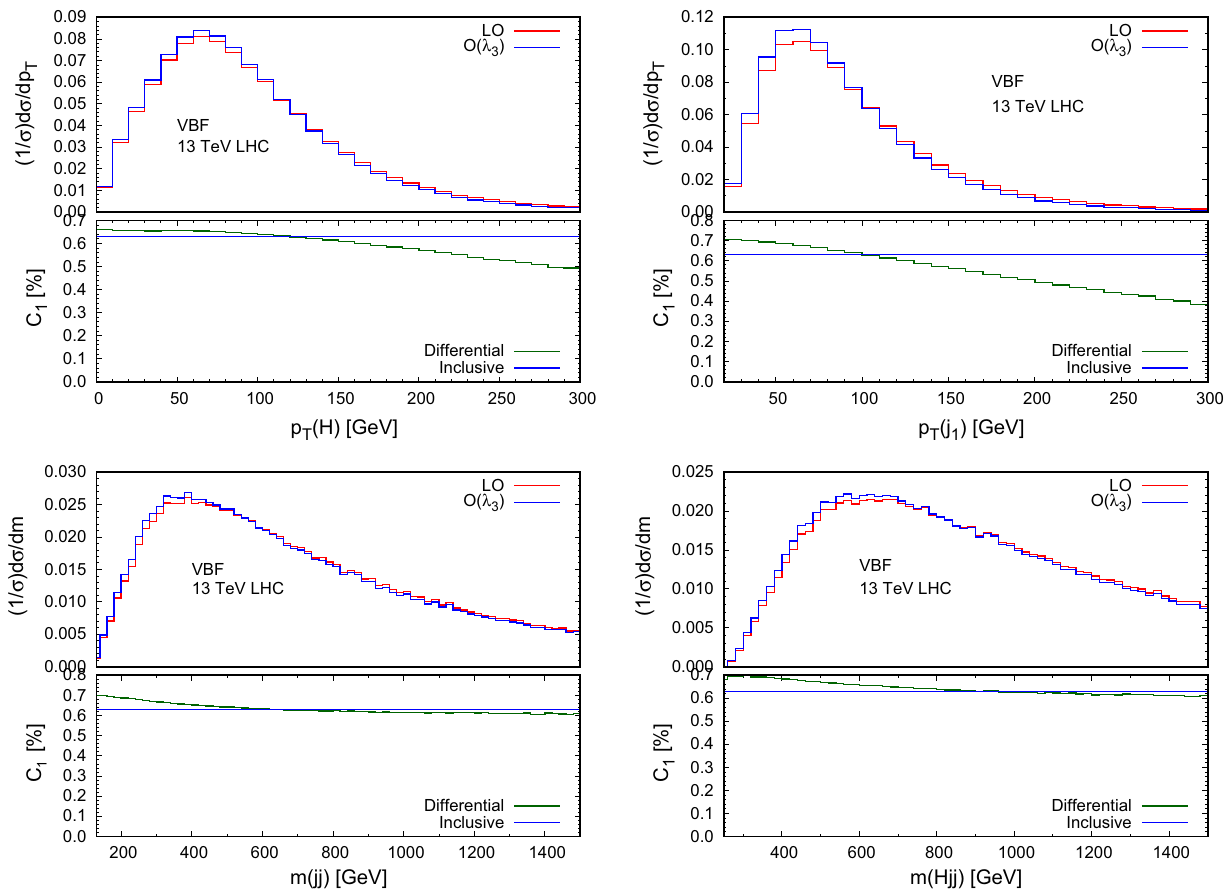
Fig. 2 Effect of O (λ 3 ) correction in VBF at 13 TeV LHC. Upper panel: normalized distributions at LO (red) and at O (λ 3 ) (blue). Lower panel: C 1 at the differential (green) and inclusive (blue)